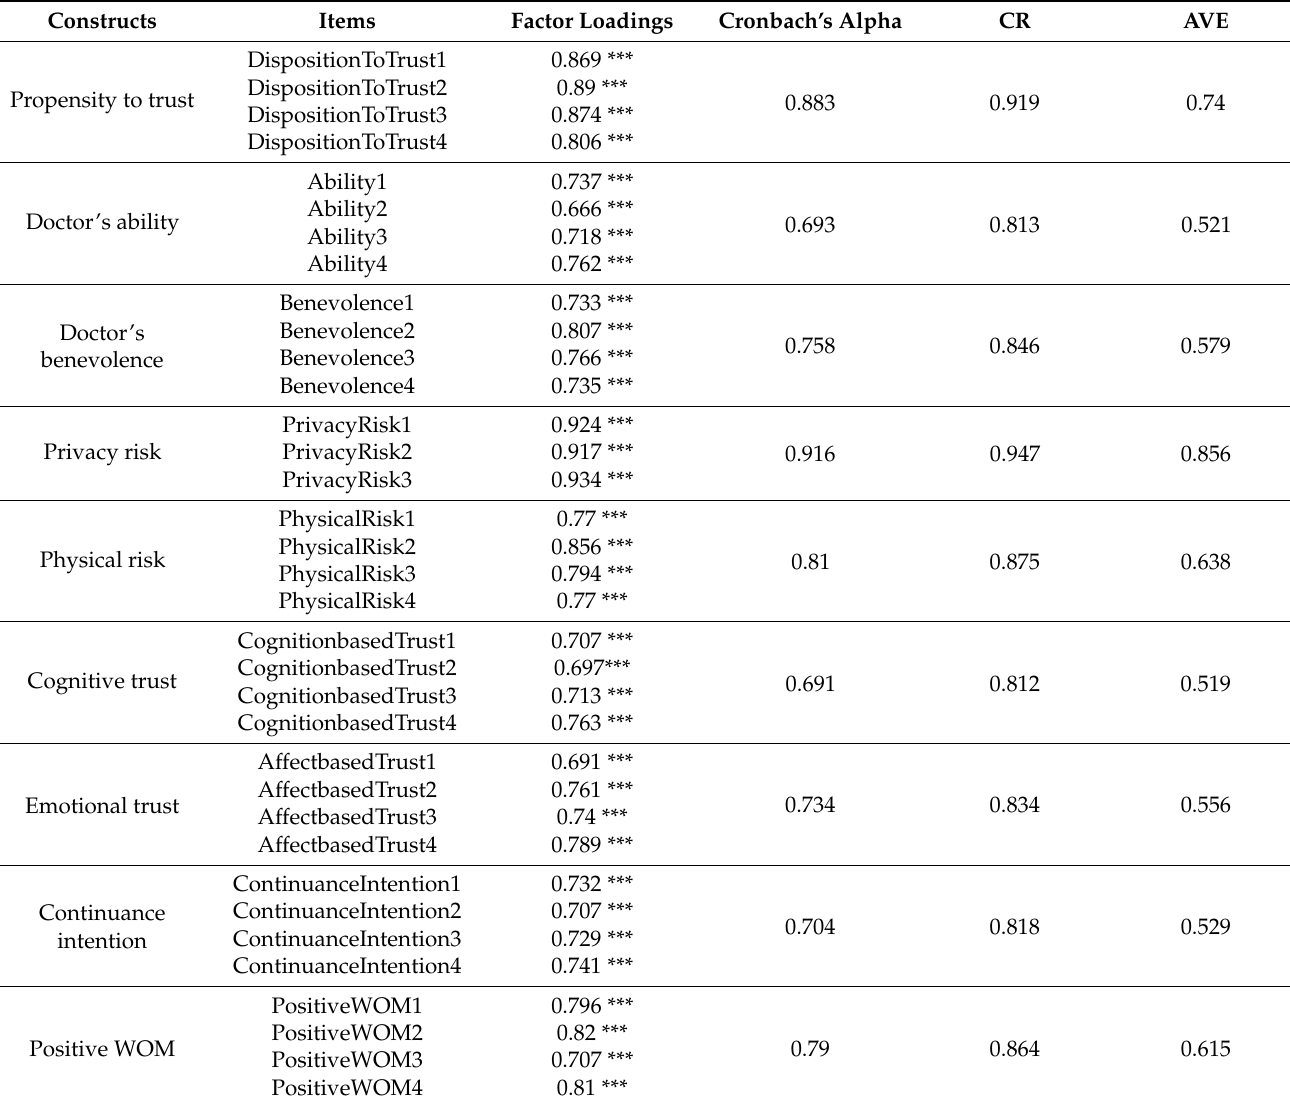
Table 3. Results of the measurement